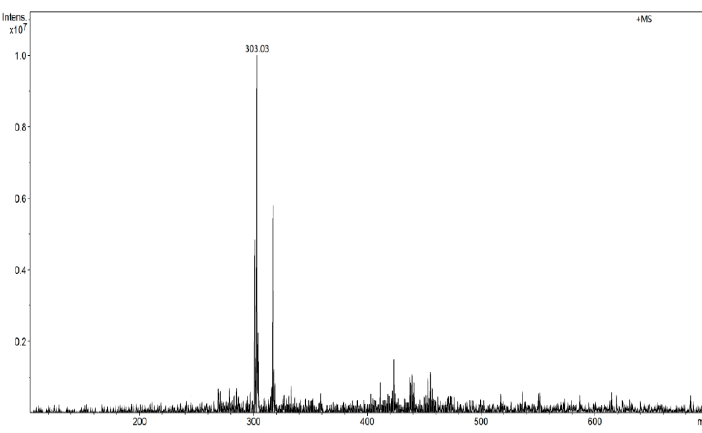
Figure 3. Flowing atmospheric-pressure afterglow (FAPA) spectrum of quercetin in the ranges of positive ions ( m / z 303 [M + H] +